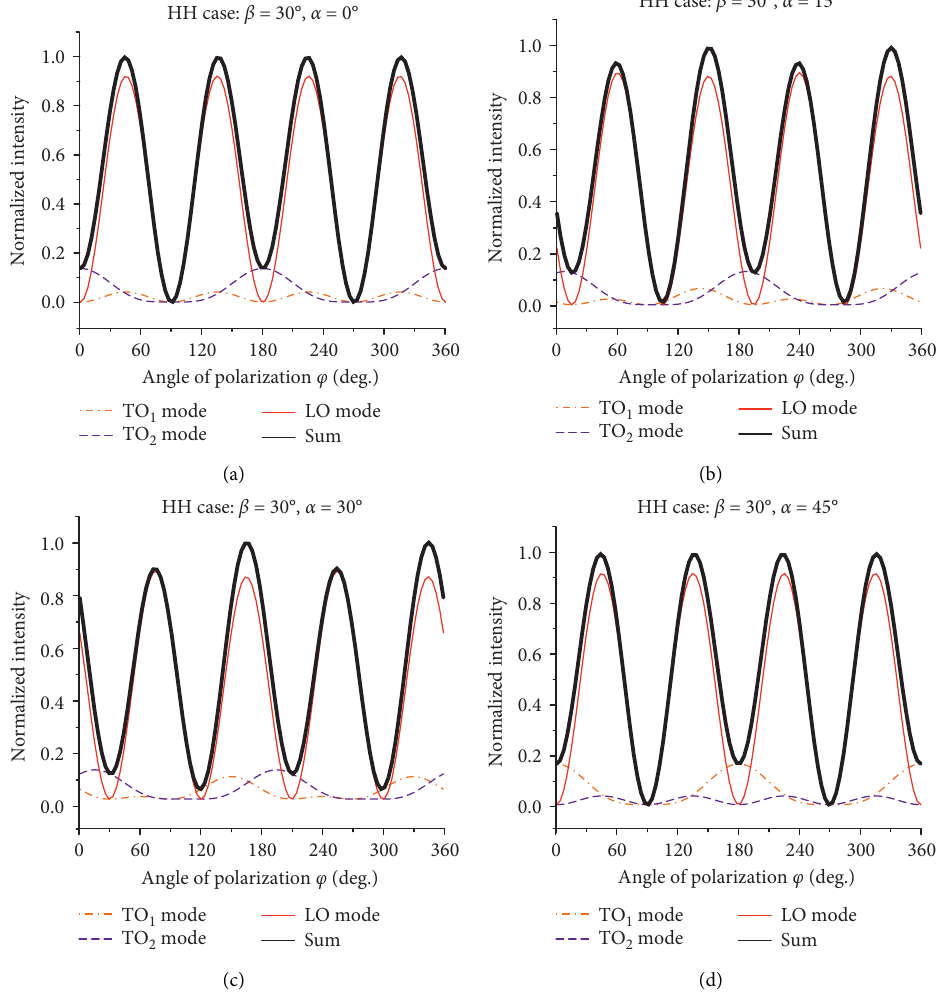
Figure 8: Intensity distributions of Raman modes in the HH case under the oblique backscattering configuration ( β � 30 ° ) for different polarization directions φ and sample rotation angles. (a) α � 0 ° , (b) α � 15 ° , (c) α � 30 ° , and (d) α � 45 °